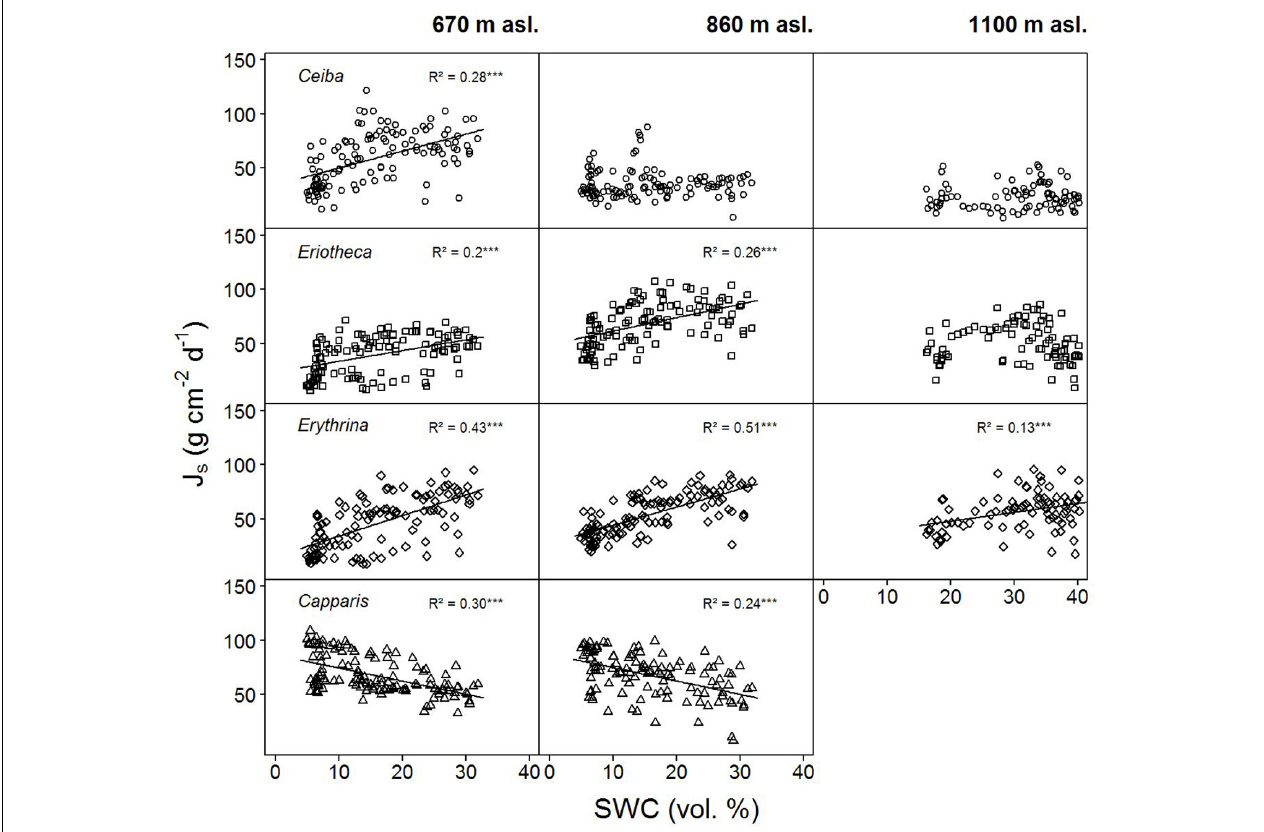
FIGURE 4 | Daily sap flux densities (Js) of the four study species versus daily soil water content (SWC). Data from January to June 2015. p < 0.0001, ‘ ∗∗∗ ’, p < 0.001 ‘ ∗∗ ’, p < 0.01 ‘ ∗ ’, p < 0.5 ‘.’, p < 0.1 ‘